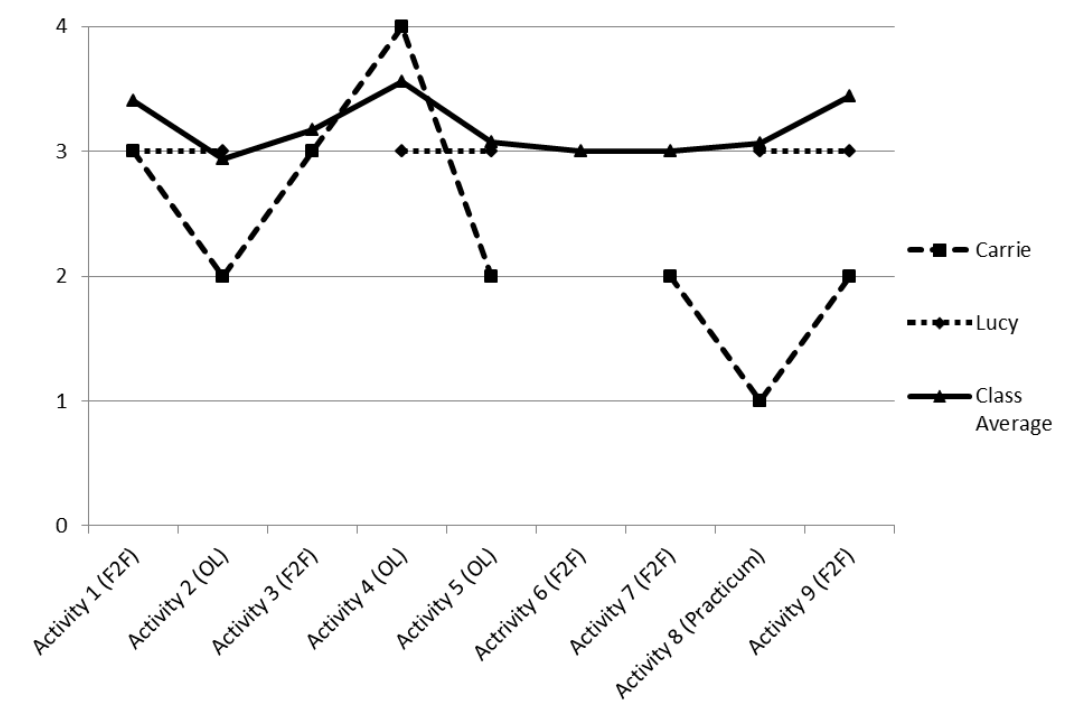
Figure 3. Comparison of Carrie’s and Lucy’s DropThought Scores to Class